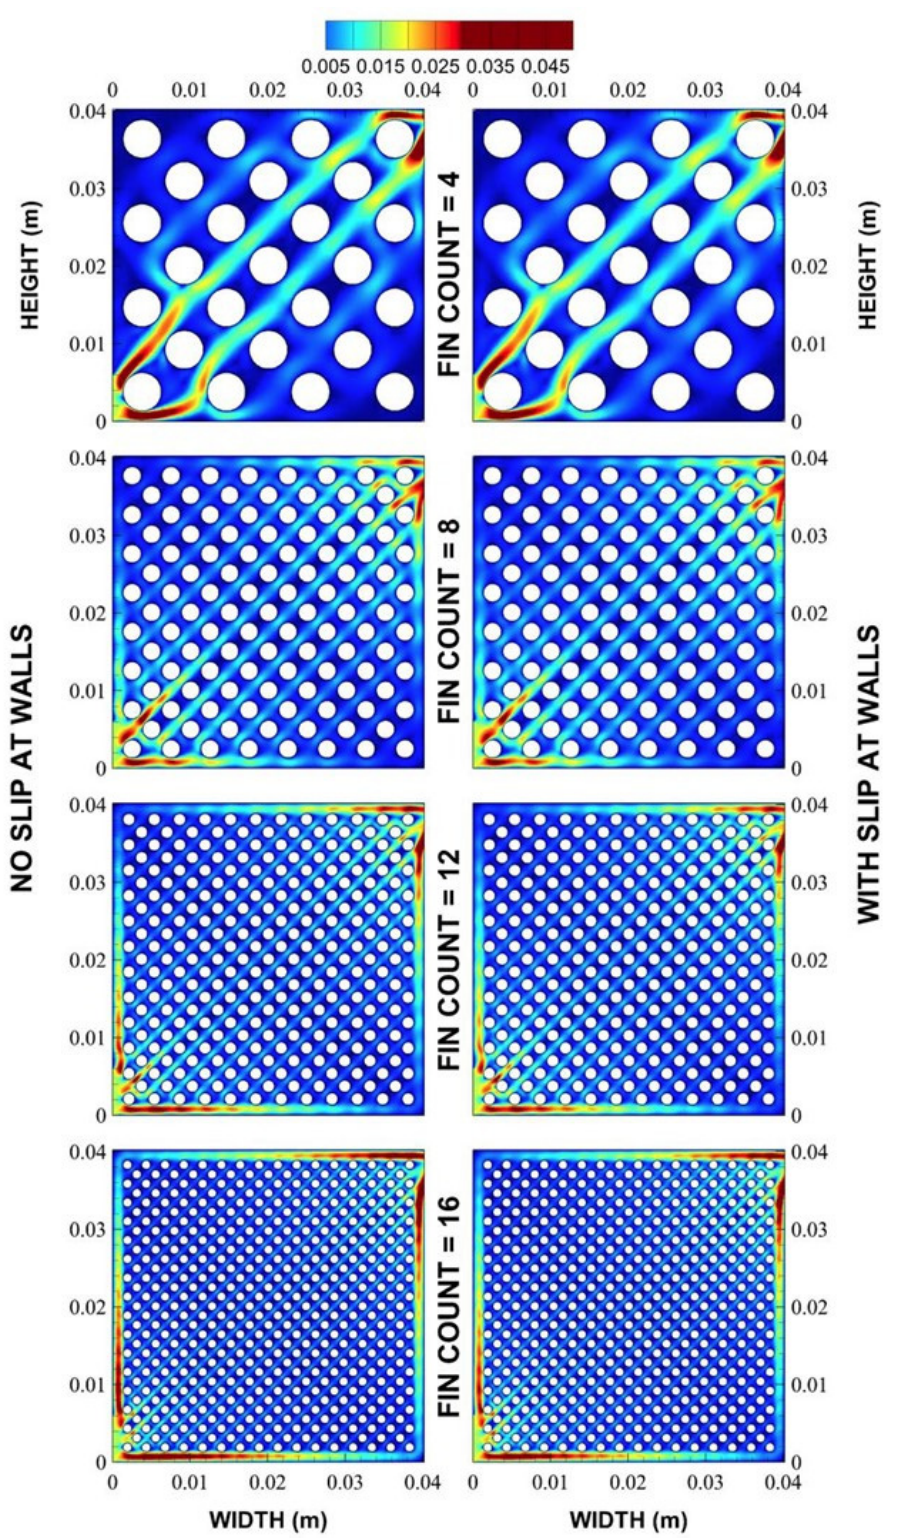
Figure 5. Velocity distribution (m / s) in the solution domain at the midheight of the fin for hydrophobic and hydrophilic fin surfaces for various number of fins and Re = 100.